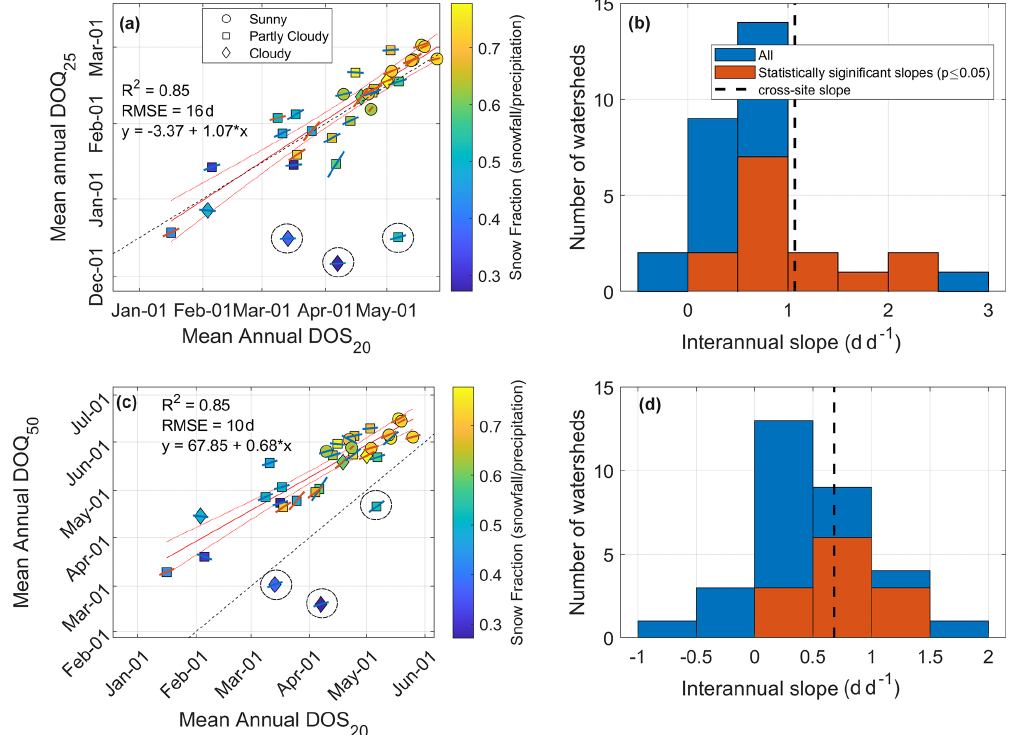
Figure 5. (a) The day when the 20th percentile of snowmelt days occurs (DOS 20 ), compared to the date of the 25% of the annual streamflow volume (DOQ 25 ). (c) DOS 20 against the date of 50% of the annual streamflow volume (DOQ 50 ). Dashed lines in panels (a) and (c) are 1 : 1 lines, and the slopes of the sites’ interannual relationships are shown as the lines on top of each symbol, with statistically significant ( p value ≤ 0.05) slopes shown in red. Site ID 24, 25, and 31, indicated by dashed circles, fall far from the linear regression and are not included in its calculation. Symbols indicate the mean annual percentage of clear-sky snowmelt days, where sunny sites (circles) have > 90% clear-sky snowmelt days, partly cloudy sites (squares) have between 70% and 90%, and cloudy sites (diamonds) have < 70%; clear-sky snowmelt days are defined as those with more than 80% of the potential clear-sky solar radiation. Panels (b) and (d) show histograms of interannual slopes (for all watersheds and those with statistically significant relationships), and the cross-site relationships are presented in their respective left